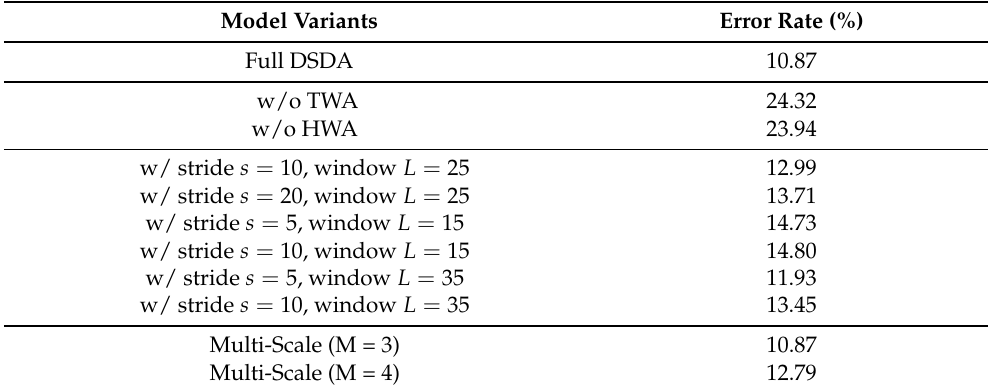
Table 5. Ablation study on model variants of DSDA on the validation split of